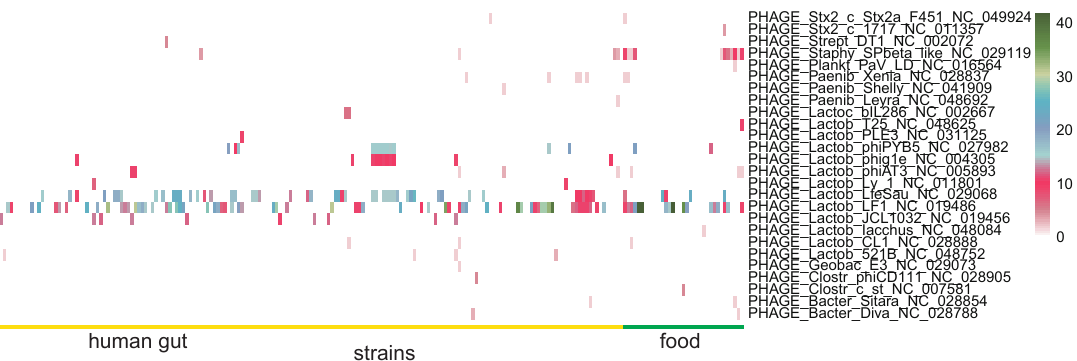
Figure 9. Identification of prophages in L. fermentum . Heatmap of the number of prophages in the genome of L. fermentum strains derived from human gut and